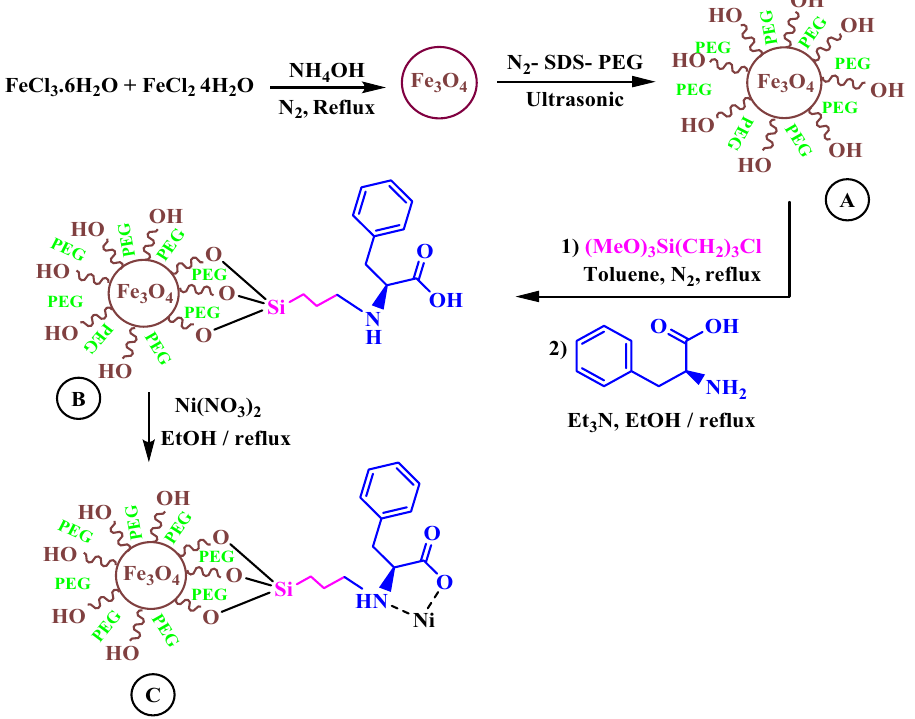
Figure 3. The stepwise synthesis pathway of Fe 3 O 4 @CPTMO-phenylalanine-Ni.